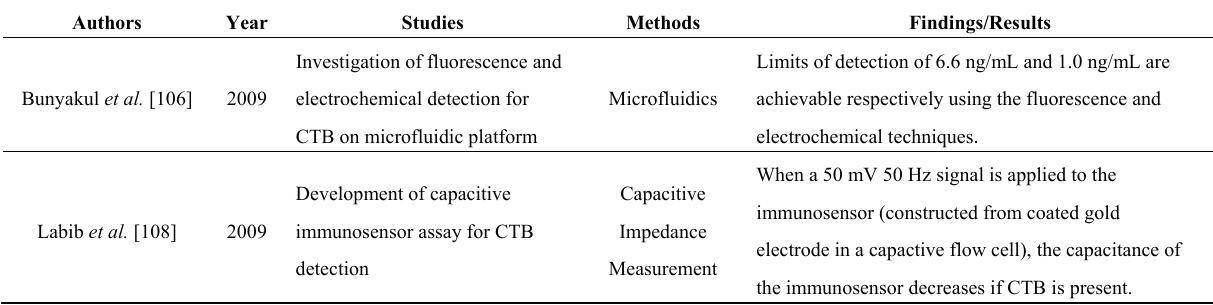
Table 6. Summary of biomedical engineering techniques in cholera